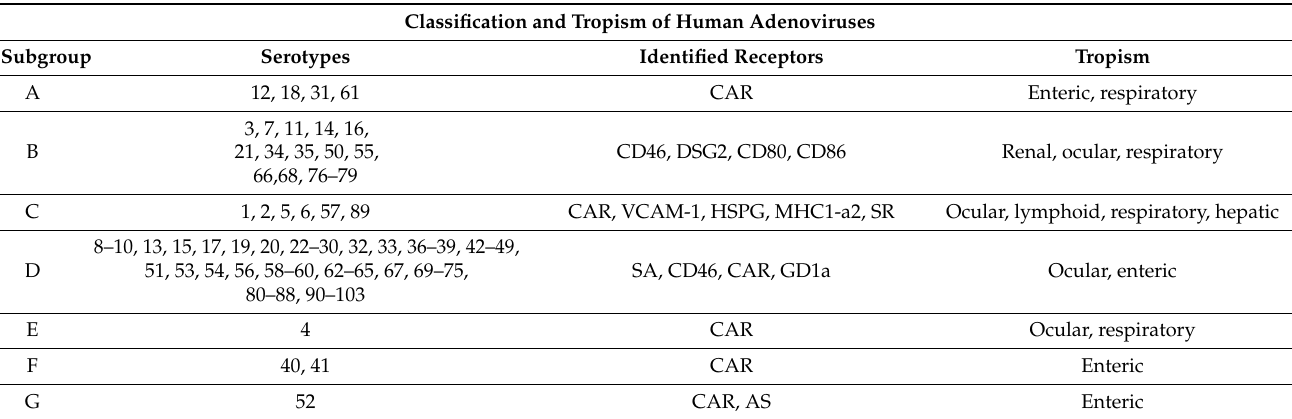
Table 2. Classification and tropism of human